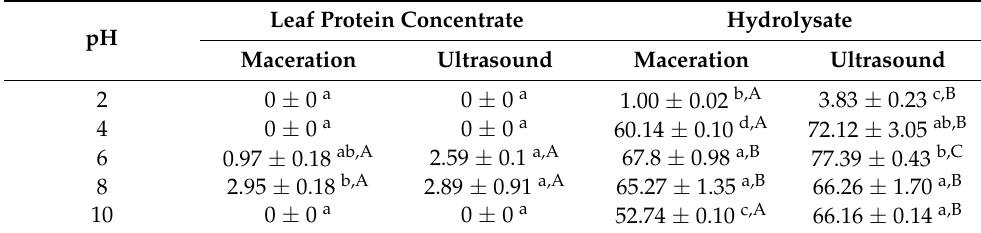
Table 2. Solubility of protein concentrates and hydrolysates at different pH. Leaf Protein Concentrate Hydrolysate pH Maceration Ultrasound Maceration Ultrasound 2 0 ± 0 a 0 ± 0